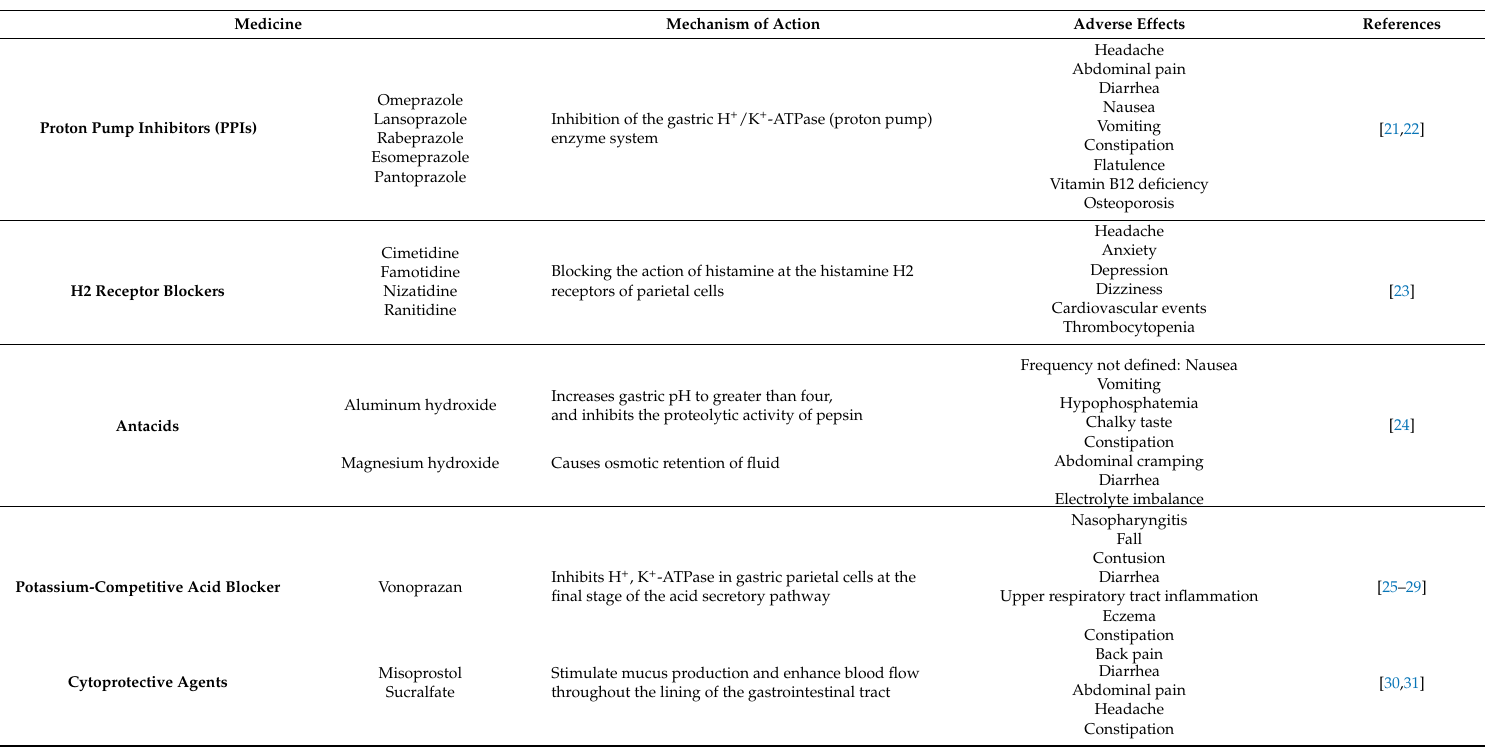
Table 1. Mechanisms of action and adverse effects of the most commonly used antiulcer treatment